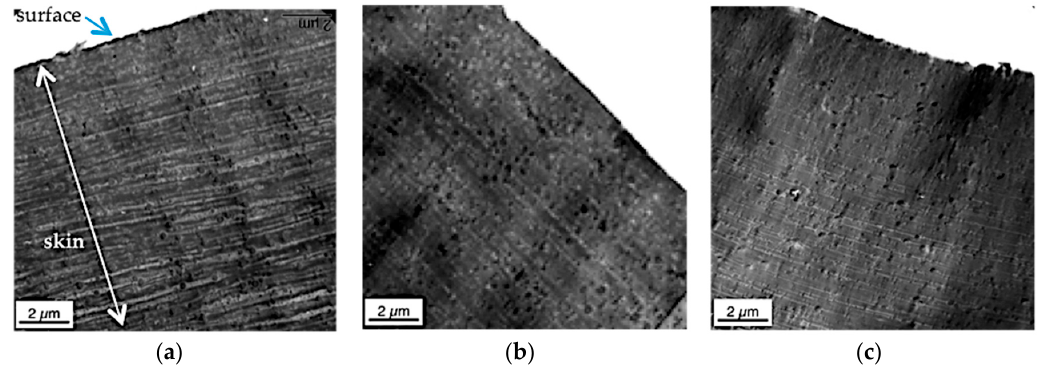
Figure 12. TEM micrographs of the skin layer (0–12 µm from the surface) taken from specimens injection-molded from PC/ABS blends with ( a ) SAN low; ( b ) SAN medium; and ( c ) SAN high.